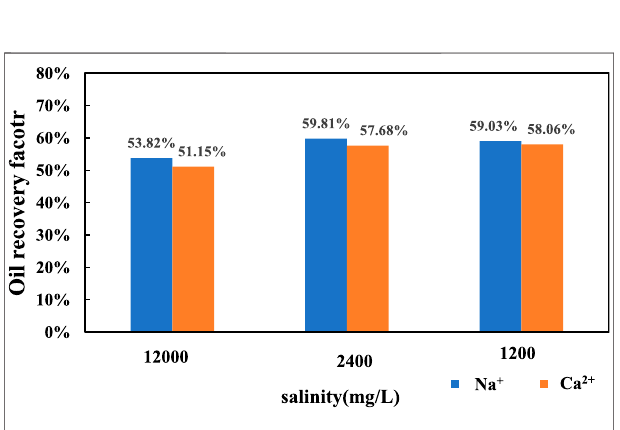
FIGURE 5 | Oil recovery of montmorillonite sand packs of different salinity brine.